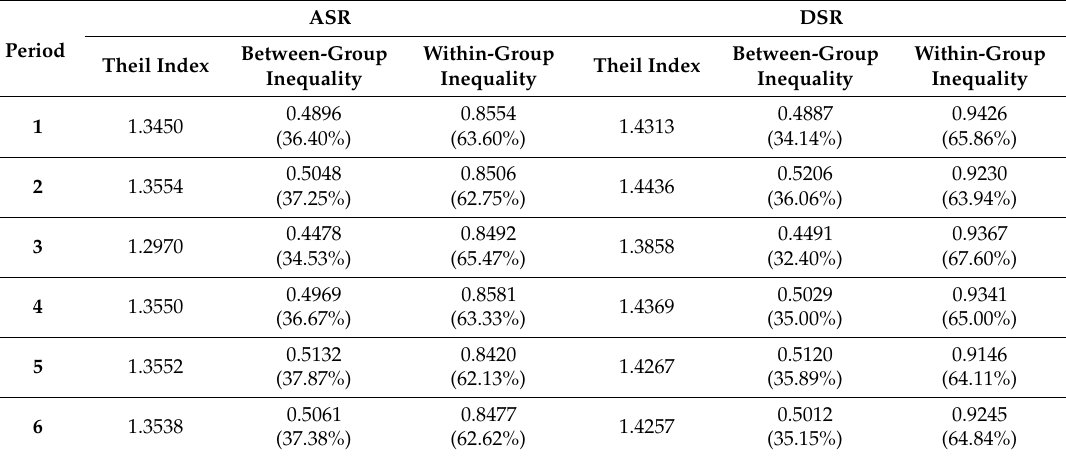
Table 5. The Theil index and its decomposition of the service rate on weekdays.